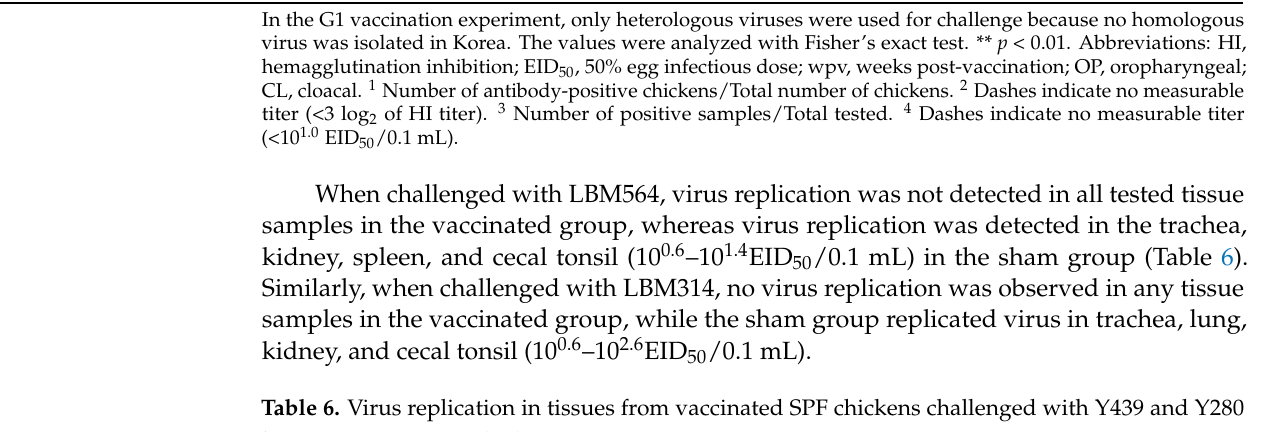
Table 6. Virus replication in tissues from vaccinated SPF chickens challenged with Y439 and Y280 lineage H9N2 viruses